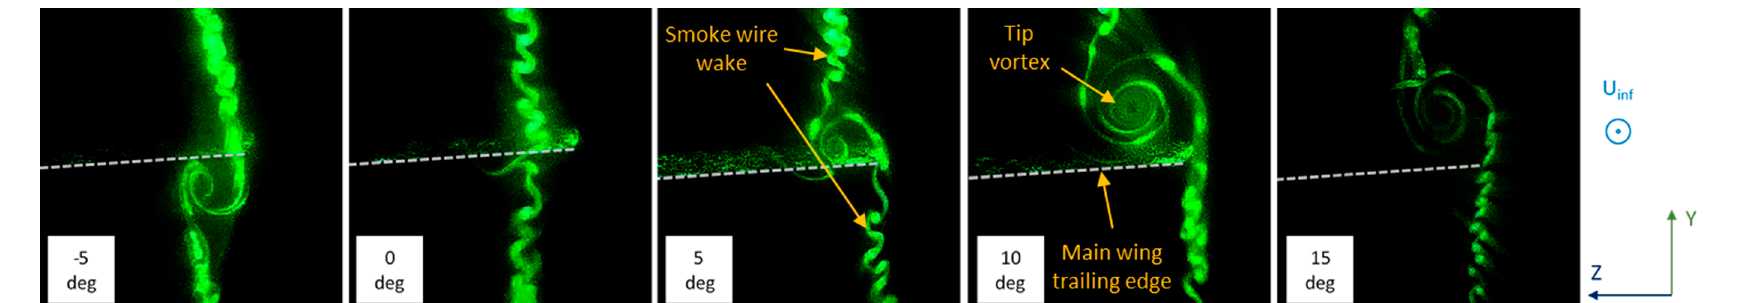
Figure 7. Smoke-probe visualization studies at the wingtip.